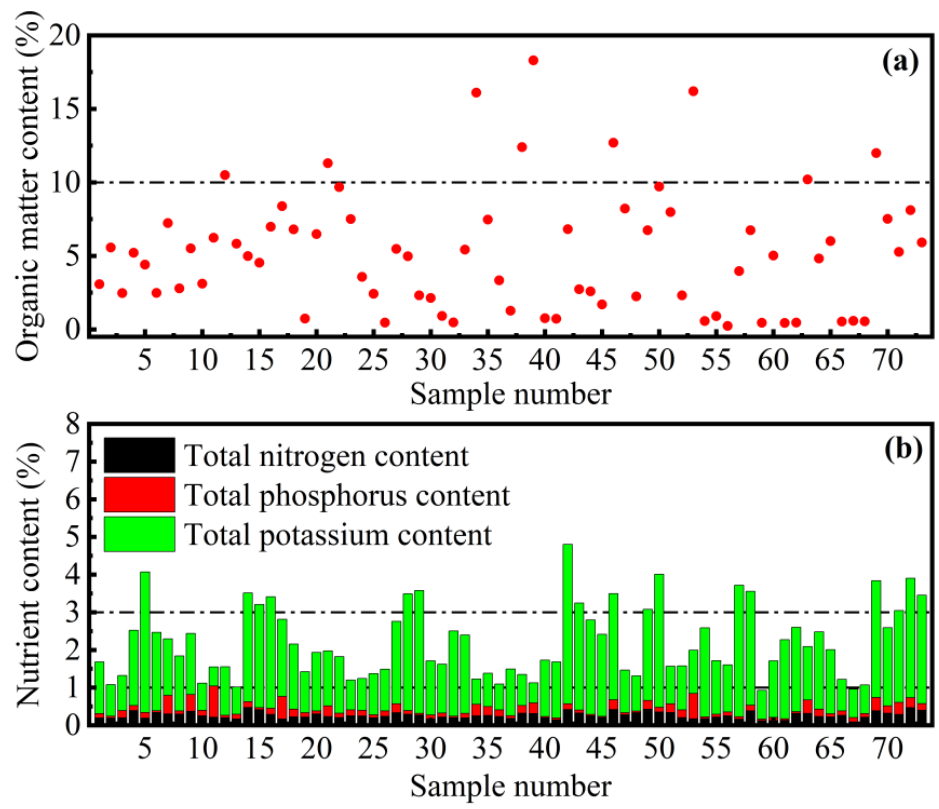
Figure 5. ( a ) OM content and ( b ) nutrient content of sewer sediment samples.